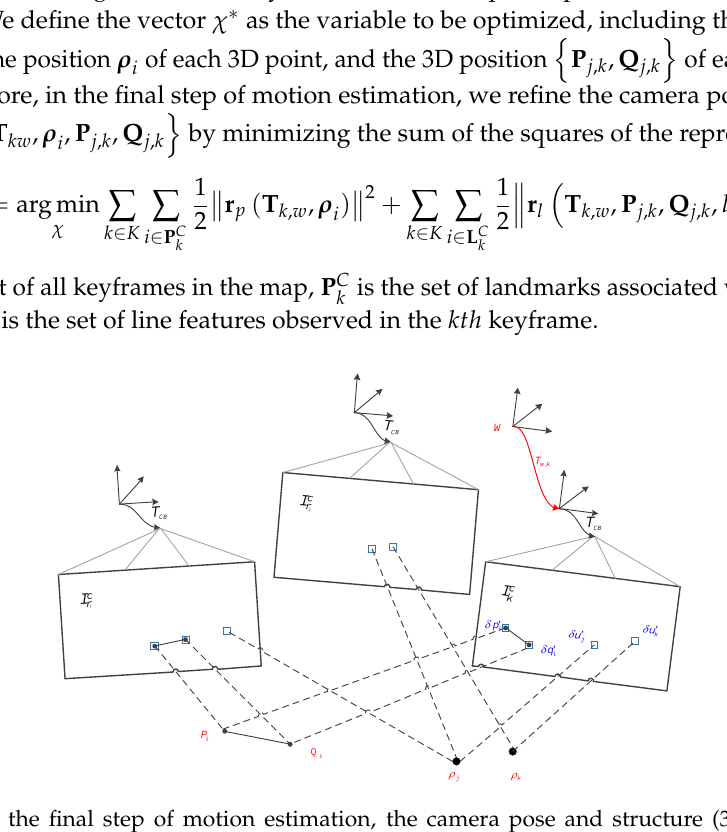
Figure 6. In the final step of motion estimation, the camera pose and structure (3D points and line segments) are optimized to minimize the reprojection errors established in the previous feature alignment